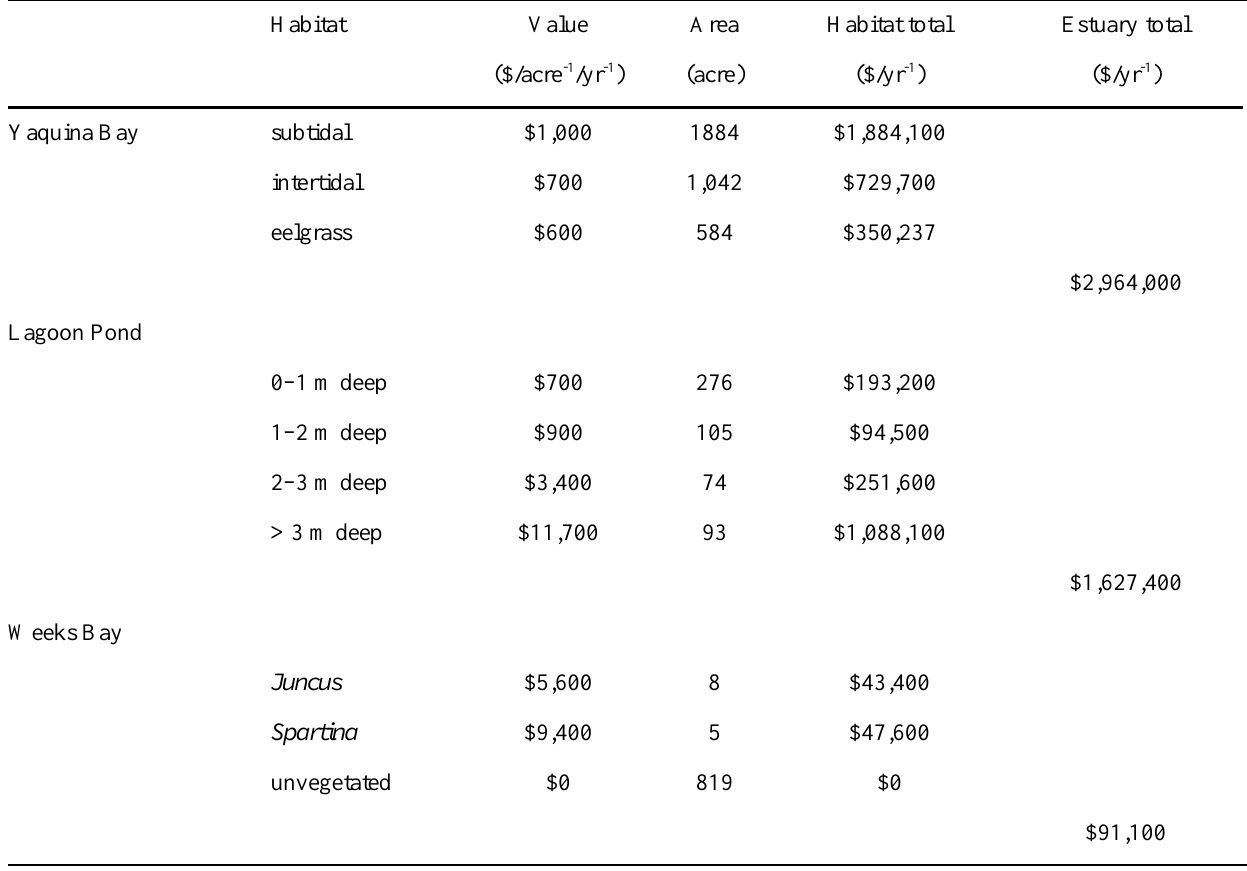
Table 4. Summary of habitat values for each estuary showing total contribution of RCFV from each habitat type in each